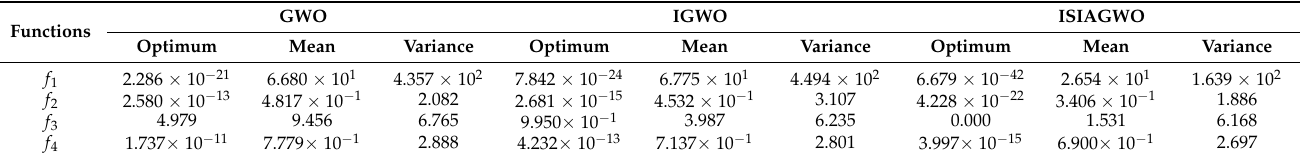
Table 2. Results of the algorithm test.